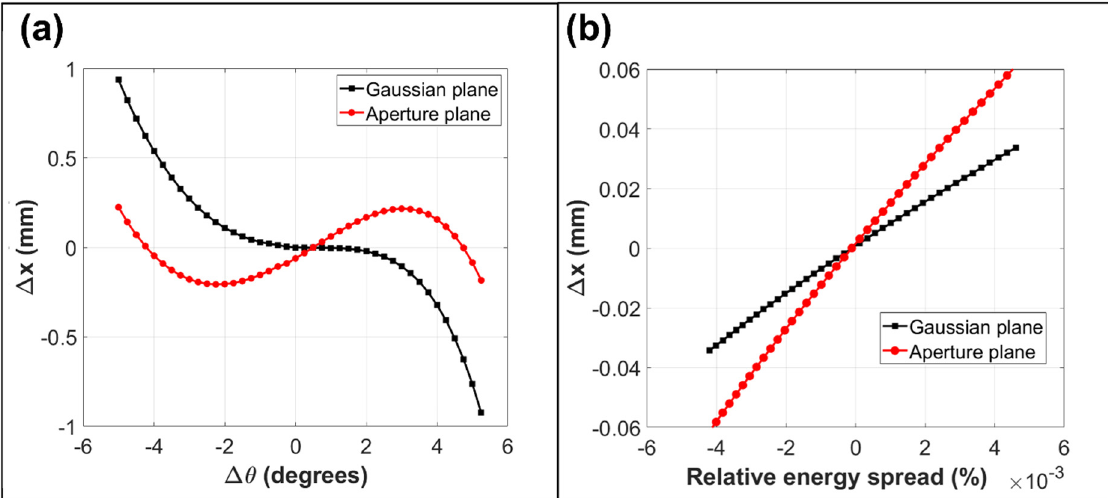
Figure 3. Simulated focusing action at the exit aperture and Gaussian planes for 1 keV BSEs retarded down to a pass energy of 10 eV. Exit distance ( ∆ x ) from the central ray as a function of ( a ) emission polar angular spread, and ( b ) the relative energy spread.